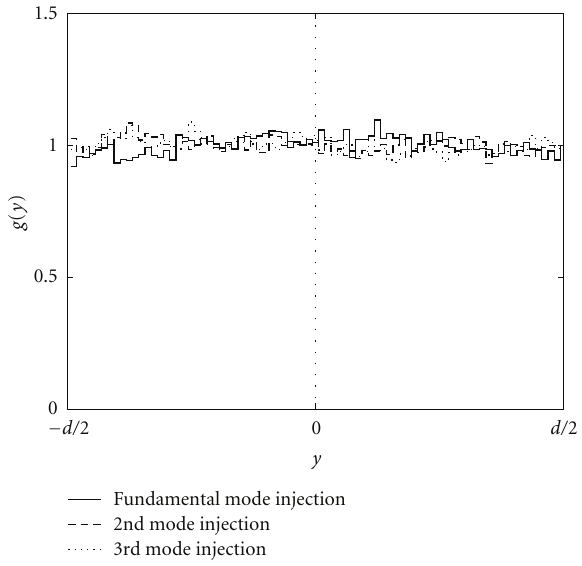
Figure 7: Spatial distributions g ( y ) of the reflected electrons for the injection of each three propagating modes.